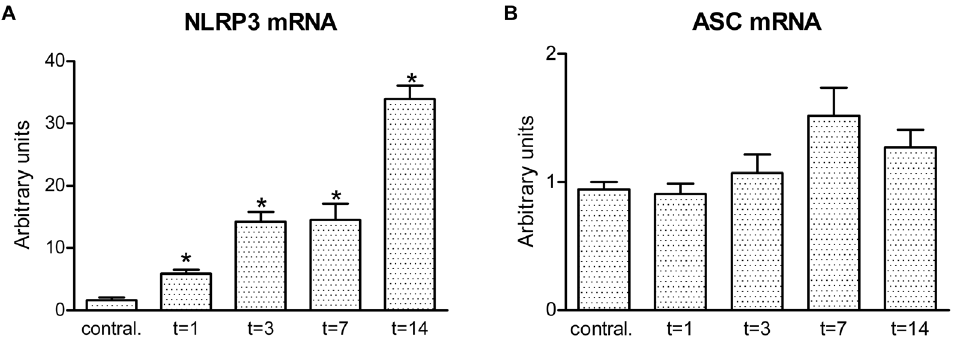
Figure 1. Progressive renal injury enhances renal Nlrp3, but not ASC mRNA expression. Relative expression levels of Nlrp3 (A) and ASC (B) mRNA in total kidney specimen following progressive renal injury. Nlrp3 mRNA expression was significantly enhanced 1, 3, 7 and 14 days post-UUO compared with contralateral kidneys, whereas ASC mRNA remained constitutively expressed. Data are mean 6 SEM of 6 mice per group. *:p , 0.05.